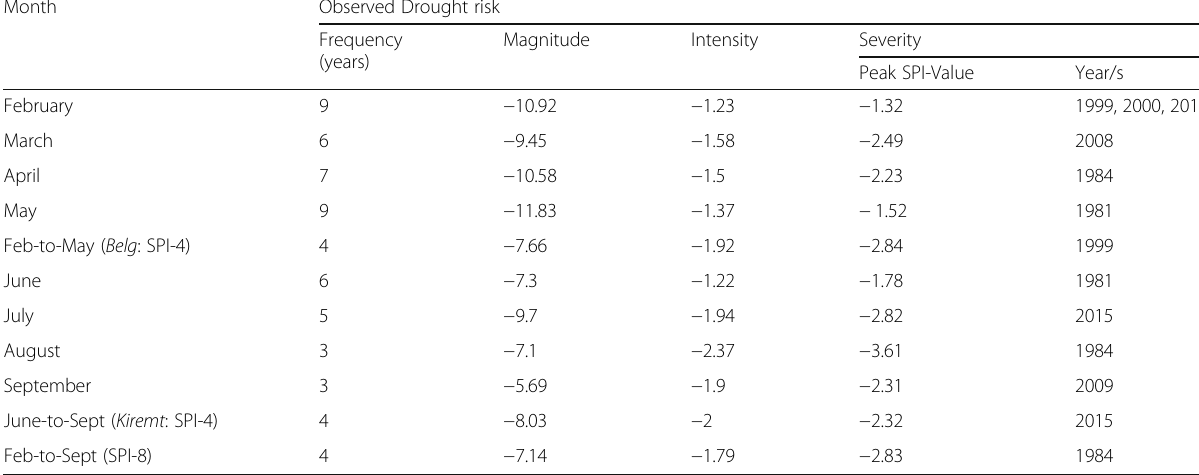
Table 2 Drought risk characteristics of the rainy months and seasons for SPI ≤ 1.0 values